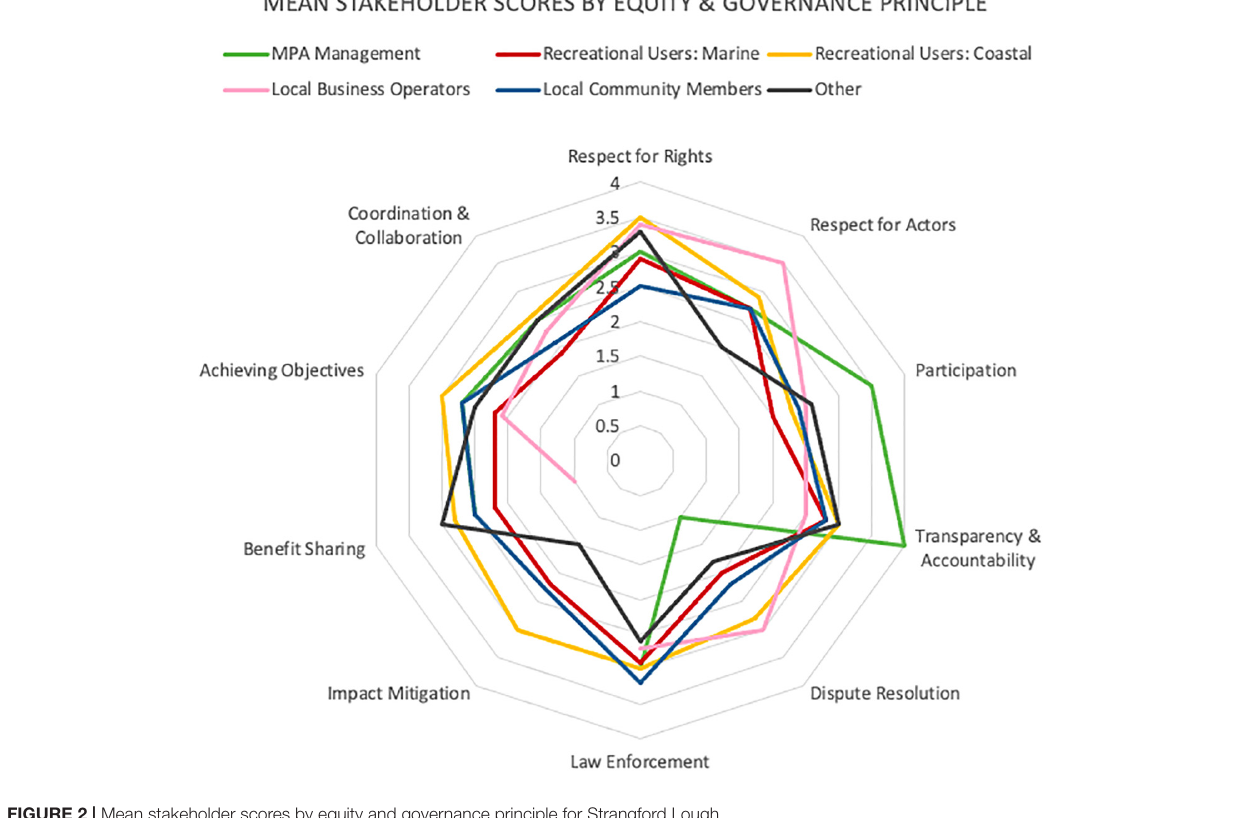
(similar scores) on the state of respect for actors (Q3, Q4, and Q5). Coordination and collaboration (Q19 and Q20) was